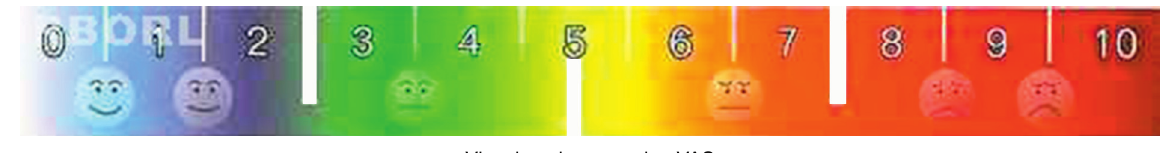
Visual analogue scale - VAS Figure 1 VAS for classification of annoyance caused by tinnitus.